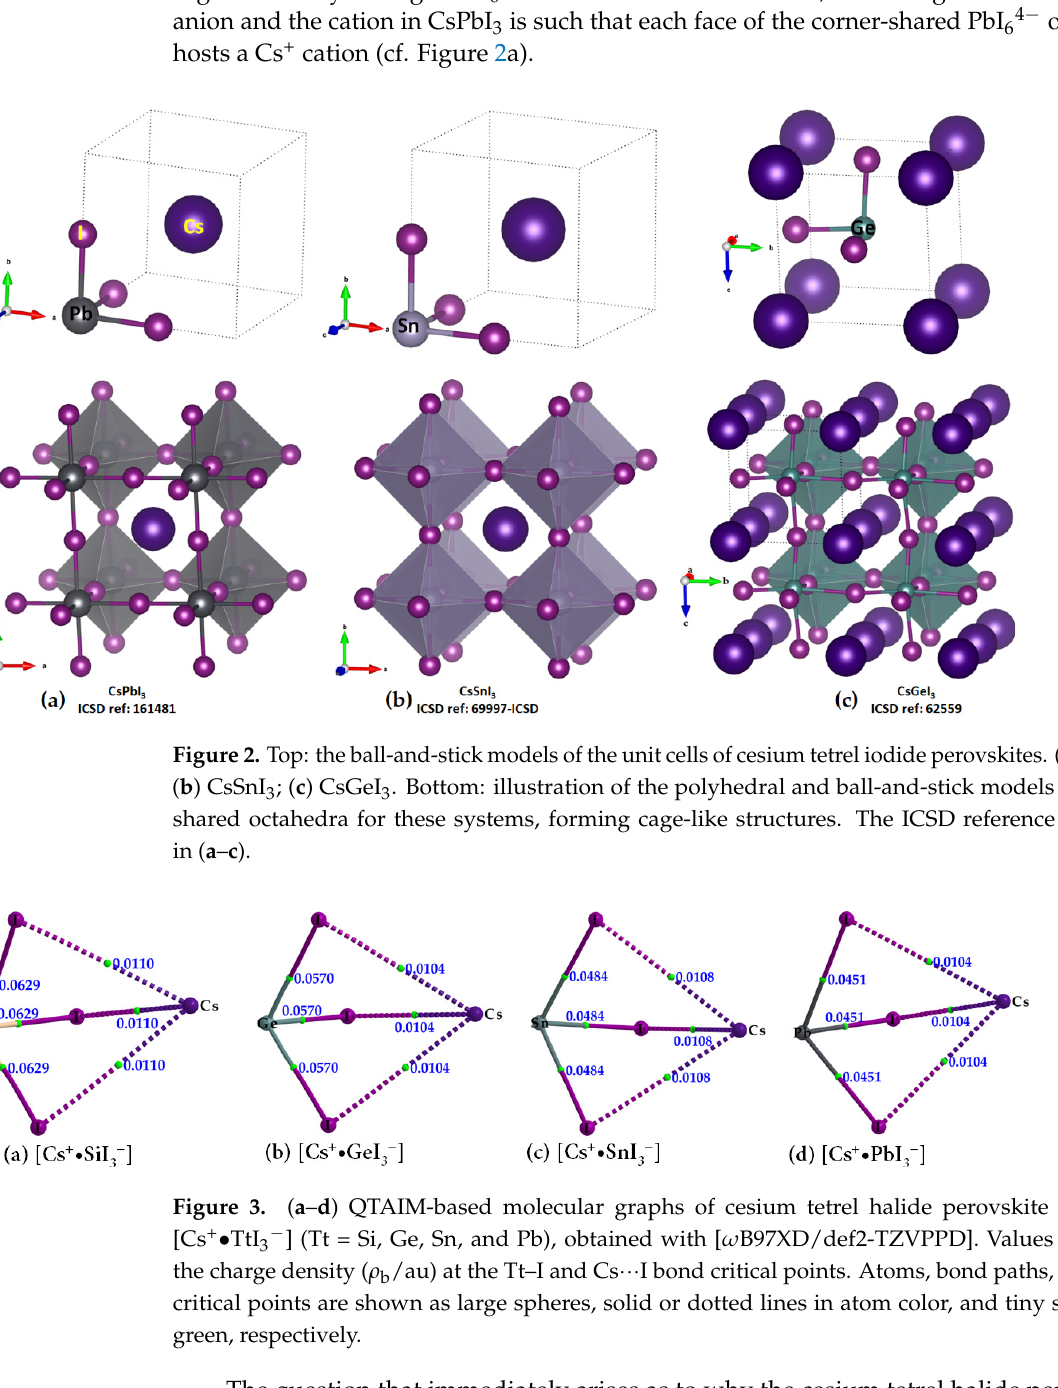
Figure 3. ( a – d ) QTAIM-based molecular graphs of cesium tetrel halide perovskite ion pairs, [Cs + •TtI 3 − ] (Tt = Si, Ge, Sn, and Pb), obtained with [ ω B97XD/def2-TZVPPD]. Values represent the charge density ( ρ b /au) at the Tt–I and Cs···I bond critical points. Atoms, bond paths, and bond critical points are shown as large spheres, solid or dotted lines in atom color, and tiny spheres in green, respectively.